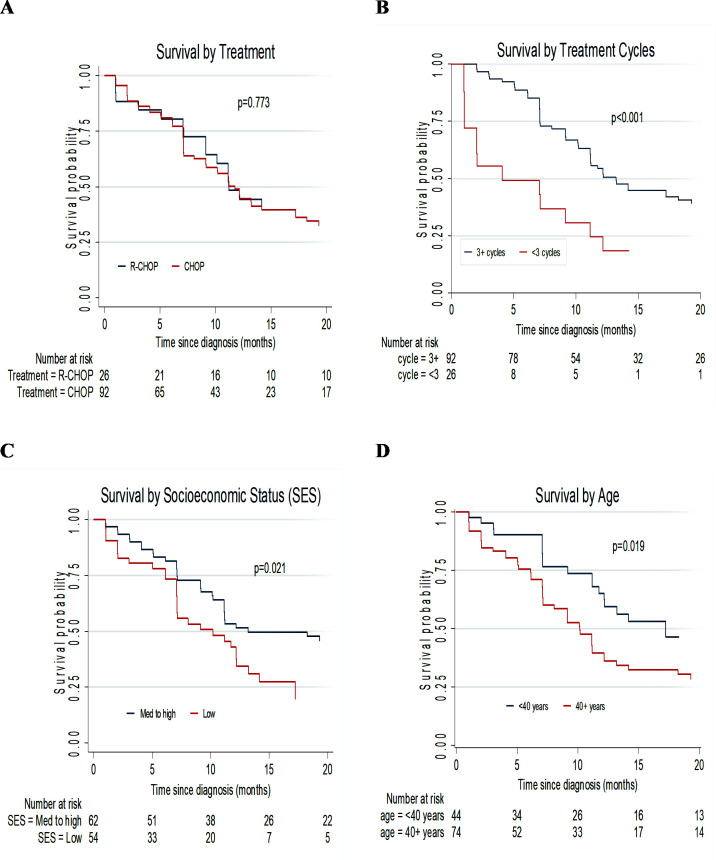
Kaplan-Meier plots comparing OS for patients with AIDS-related lymphomas according to: (A) NHL Treatment, (B) Number of cycles received, (C) Socioeconomic status and (D) Age <40 years and 40+ years.